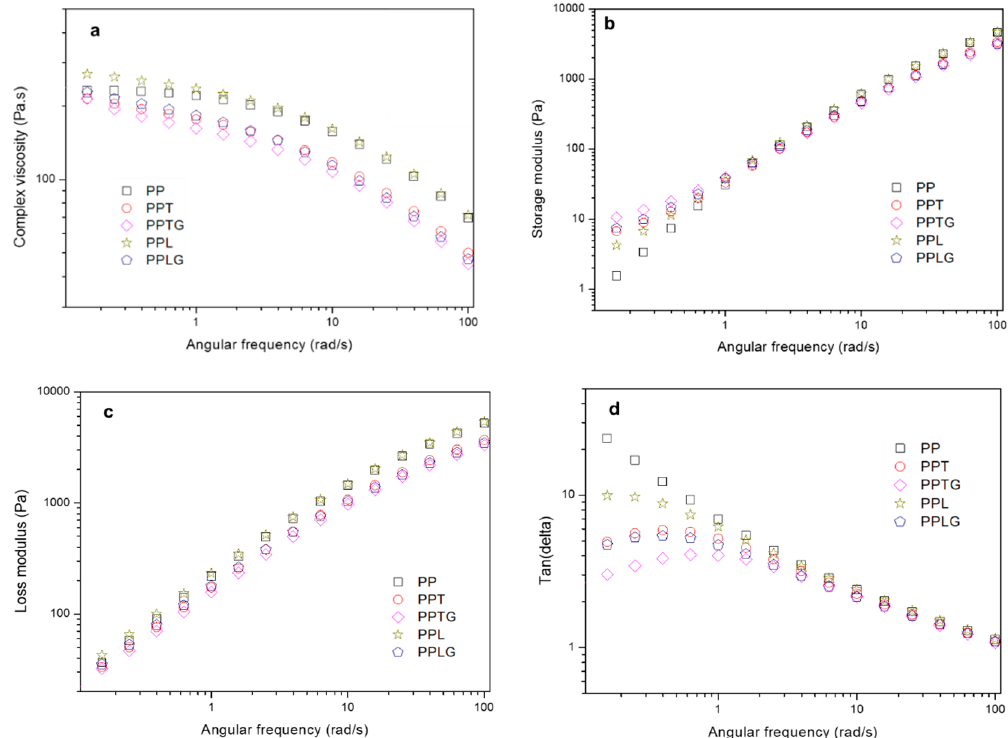
Figure 6. Rheological behaviors of PP, PP / polyphenol blends, and PP / crosslinked polyphenol blends: ( a ) complex viscosity; ( b ) storage modulus; ( c ) loss modulus; ( d ) tan(delta).